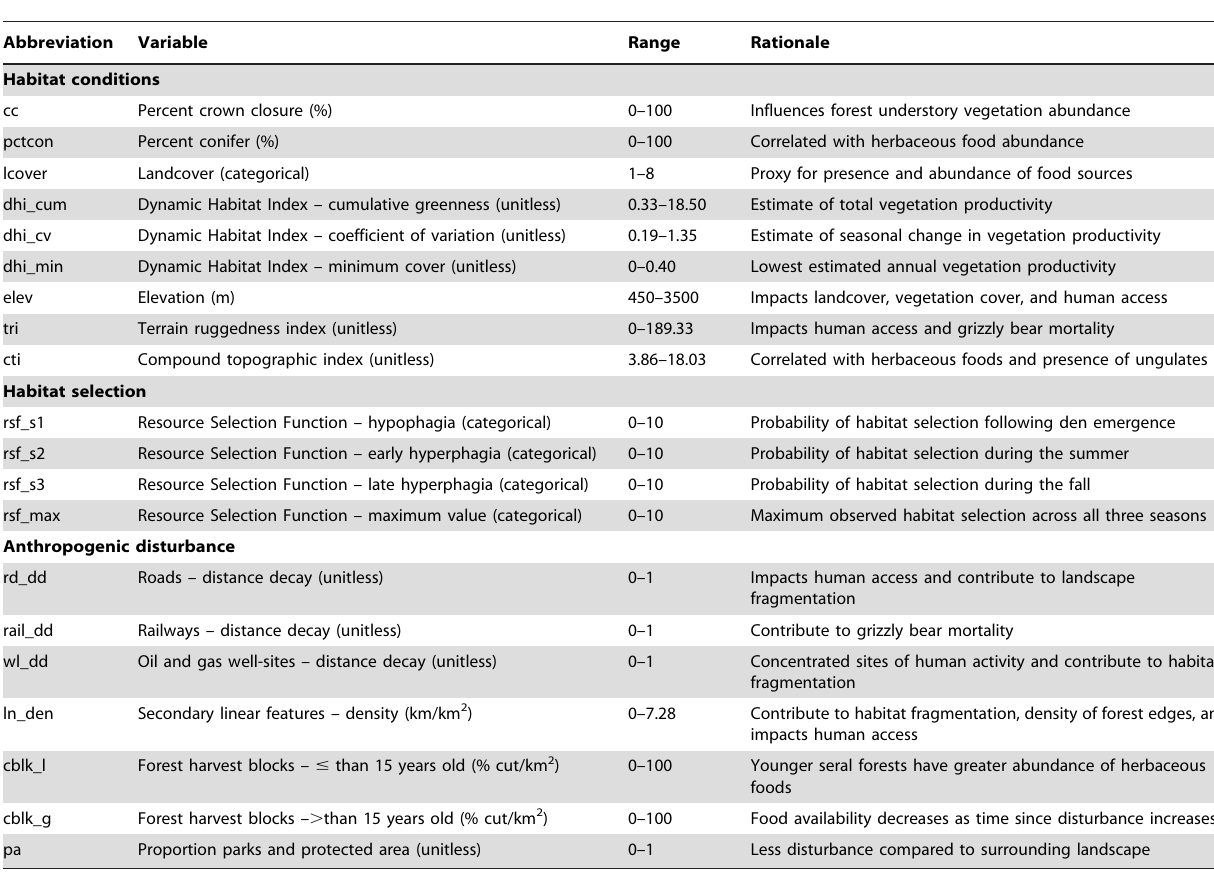
Table 1. Variables used to predict HCC levels in grizzly